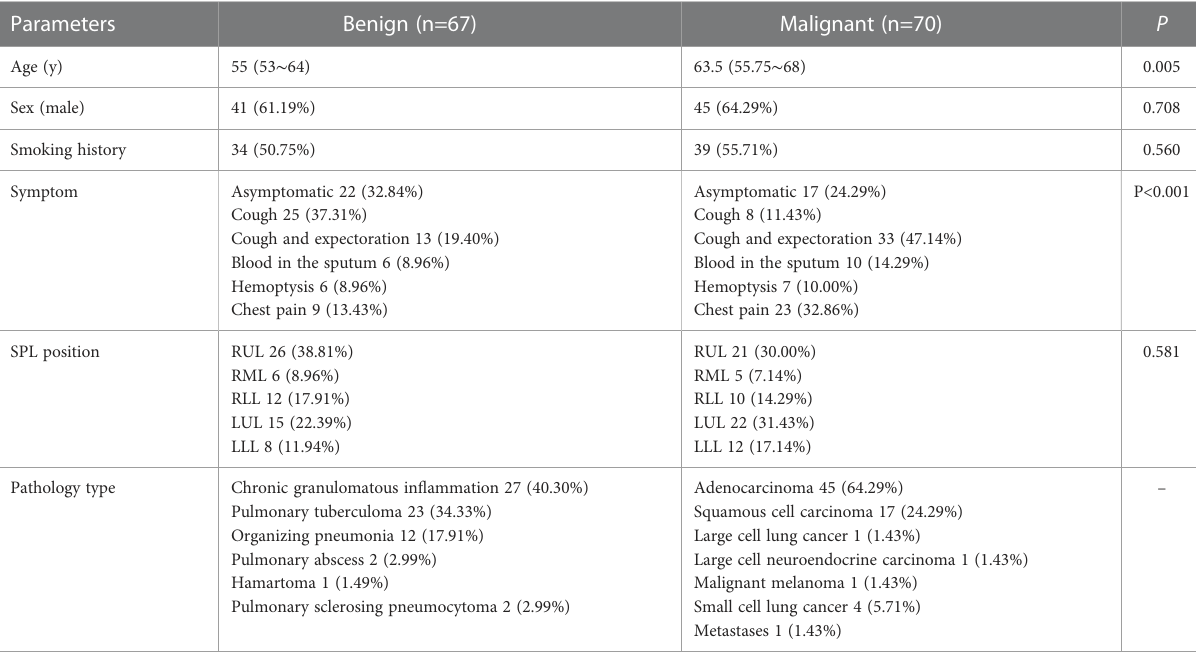
TABLE 1 Comparison of clinical and imaging data between benign and malignant solitary pulmonary lesions.